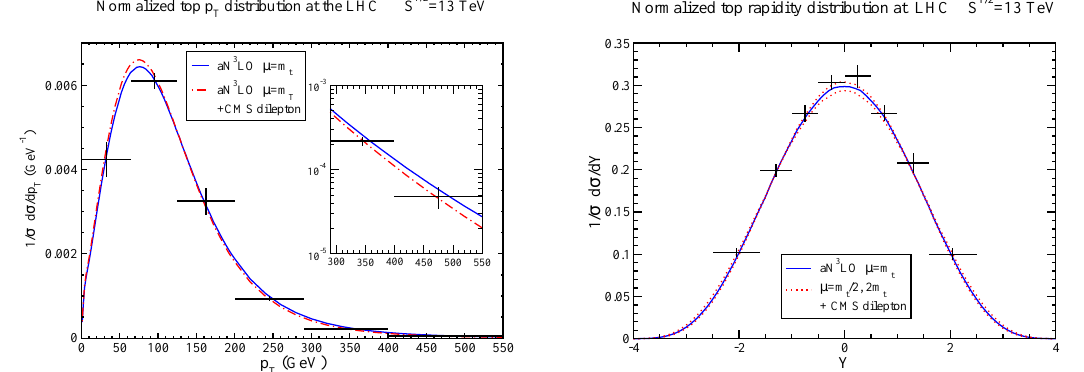
Figure 5. aN 3 LO top-quark normalized p T (left) and rapidity (right) distributions at 13 TeV energy compared with CMS [47]